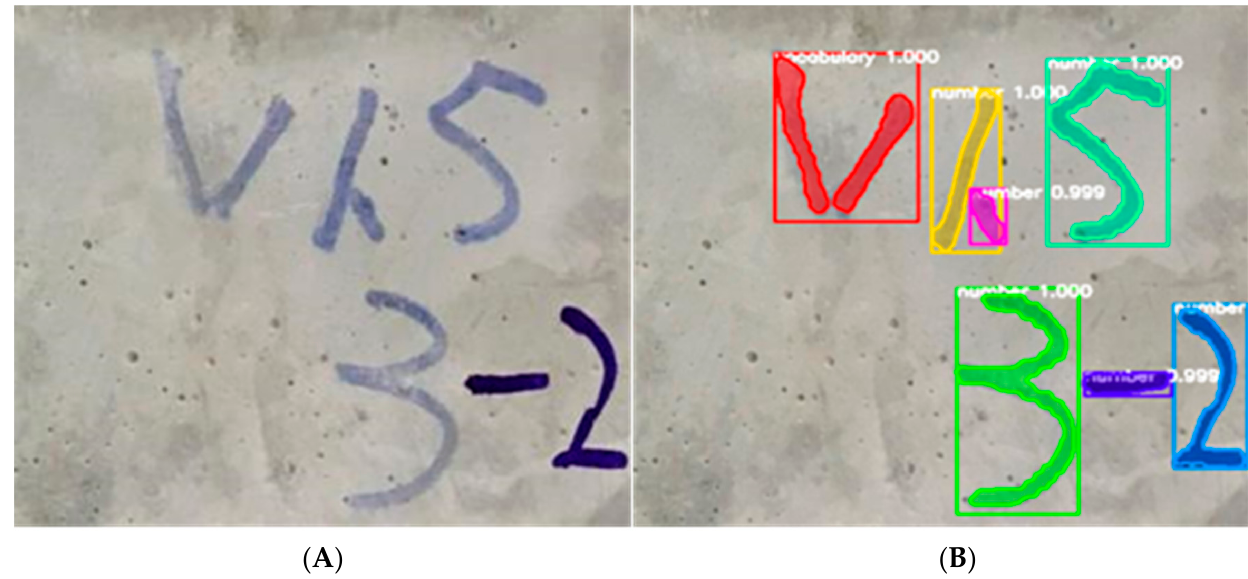
Figure 11. Detection result. ( A ) Original image; ( B ) target detection results, including three parts: bounding box, mask, and confidence.